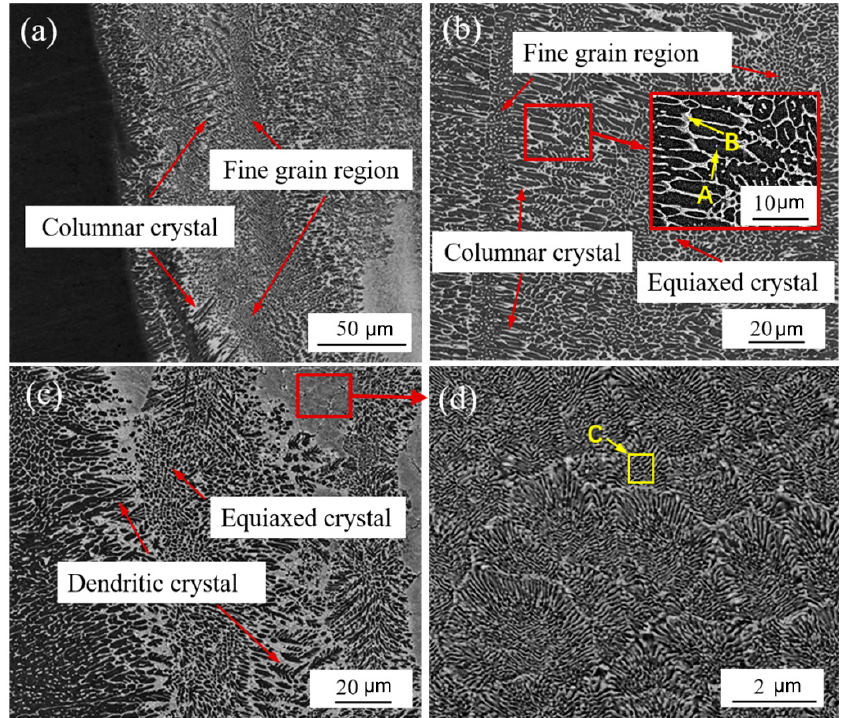
Figure 6. Microstructure of steel side weld: ( a , b ) microstructure near the fusion line; ( c ) microstructure in the middle of weld; ( d ) partial enlargement of C figure. Table 6. EDS results of steel side welds (at.%).